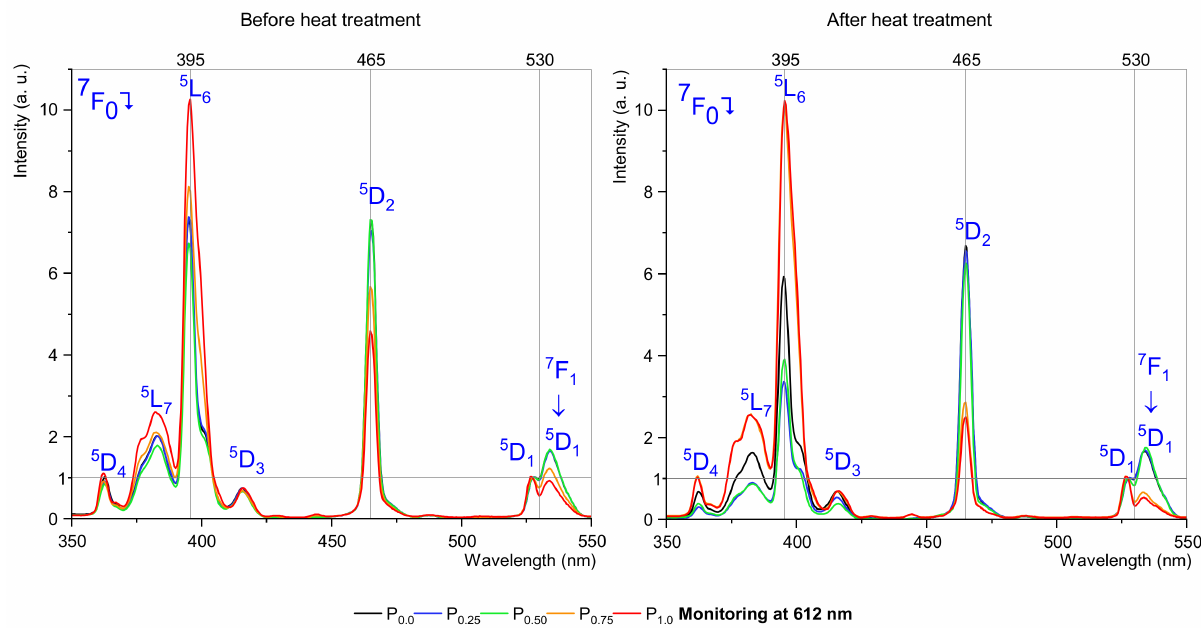
Figure 3. Excitation spectra, monitoring at 612